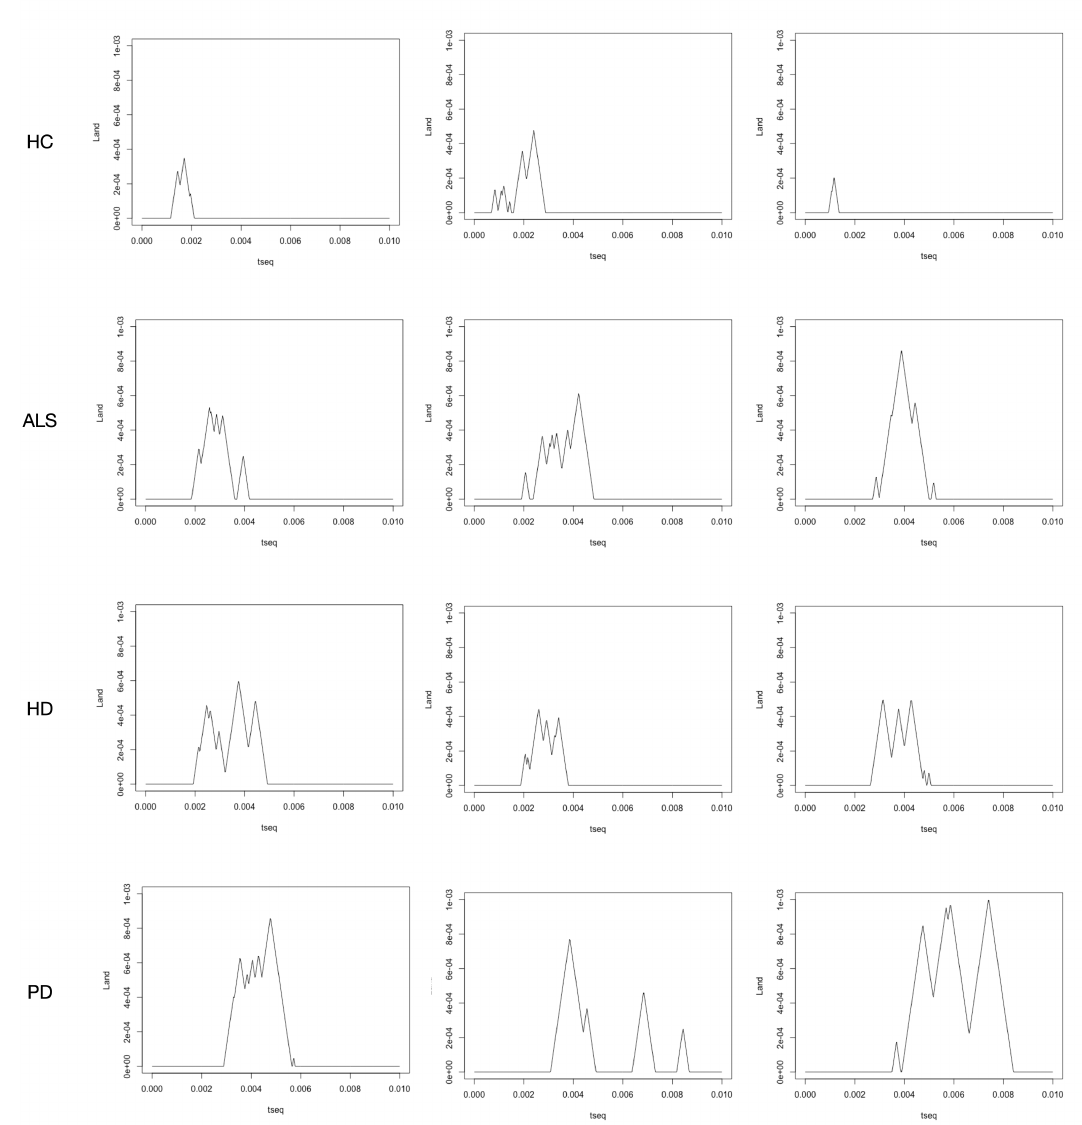
Figure 10. The persistence landscapes corresponded to Figures 8 and